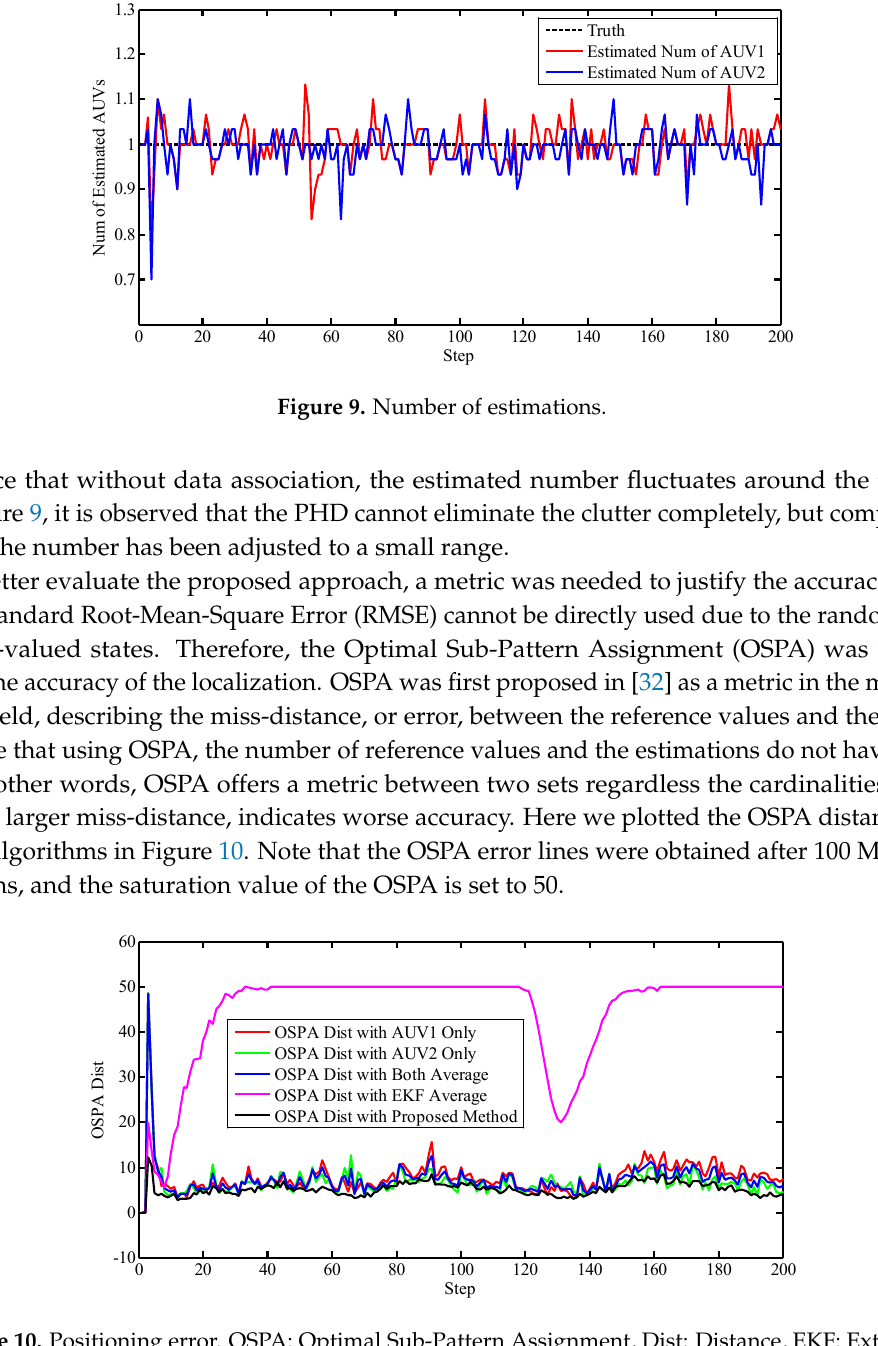
Figure 10. Positioning error. OSPA: Optimal Sub-Pattern Assignment, Dist: Distance, EKF: Extended Kalman